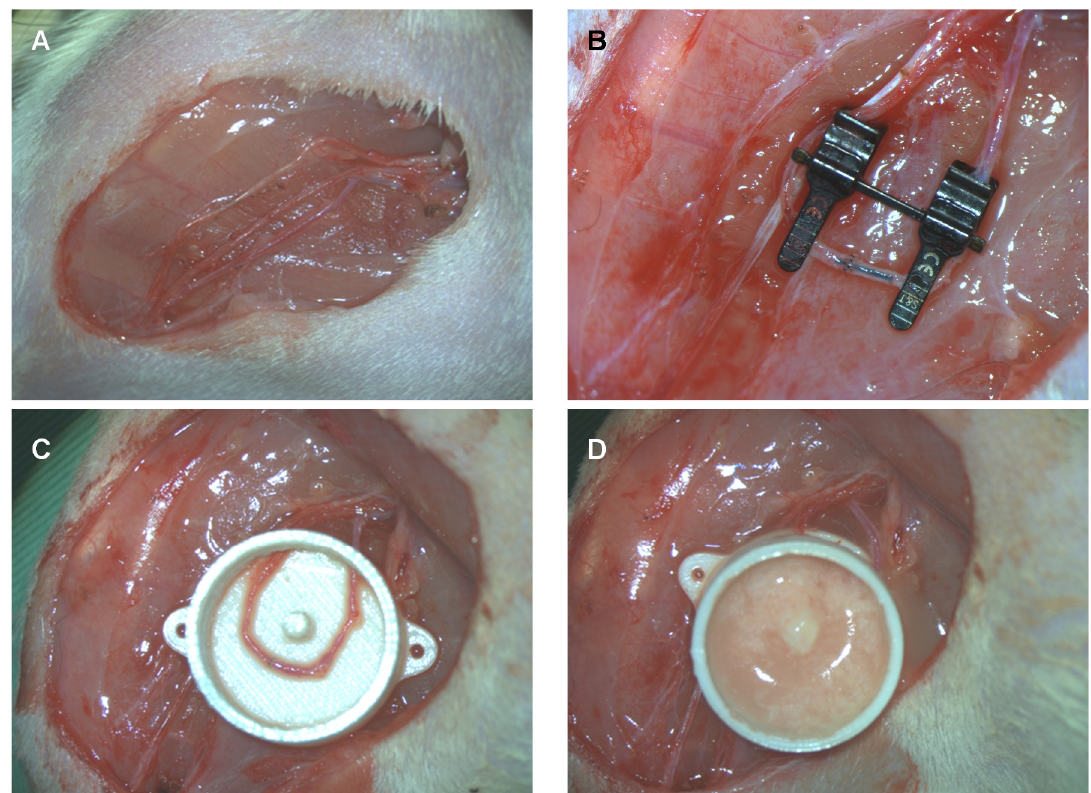
Figure 2. Arteriovenous shunt of the saphenous artery and vein in rats. ( A ) The saphenous artery and vein as well as the obturator nerve were dissected on each leg. ( B ) On the experimental side, the saphenous artery and vein are anastomosed in the knee region just proximally to their bifurcation. On the control side, no AV shunt is established. To prevent stitching of the back wall, a black 4/0 nylon suture is inserted into the lumen and removed before tying the last stitch. ( C ) The AV shunt is placed into a polycarbonate tissue engineering chamber. ( D ) The chamber is filled with an mSVF-fibrin hydrogel mix and closed by a lit. On the control site, the chamber is filled with an mSVF-fibrin hydrogel mix which is not vascularized by an AV shunt.